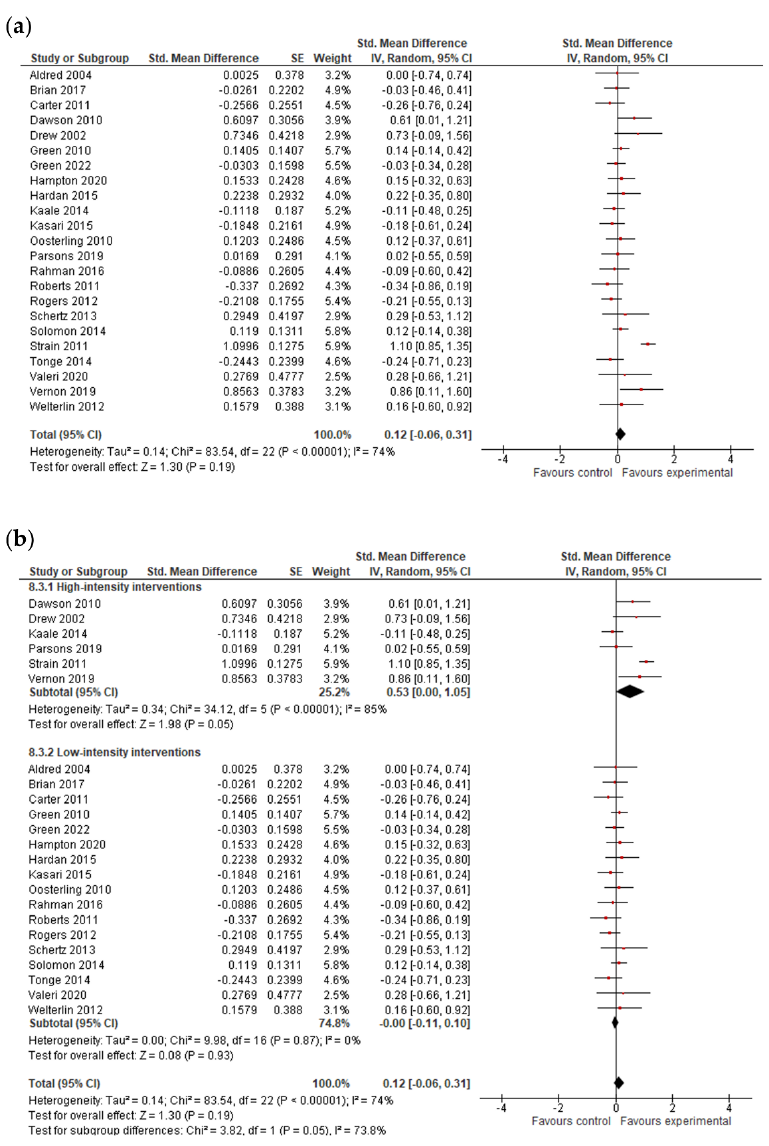
Figure 5. Forest plots for receptive language results. ( a ) Overall effect